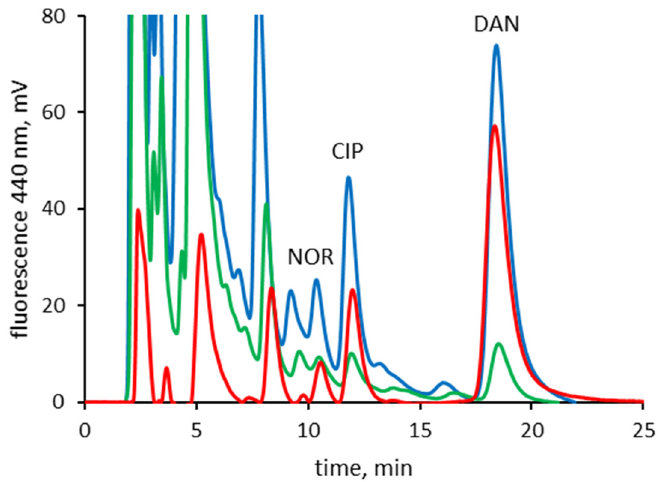
Figure 6. HPLC chromatogram of human urine spiked with ciprofloxacin, danofloxacin, and nor- floxacin at final concentration of 2 µg mL − 1 and diluted 9 + 1 v / v with 50 mmol L − 1 MES buffer, pH 4.5. Blue line: sample injected without MISPE; green line: not retained eluate from MISPE cartridge; red line: eluate from MISPE cartridge.